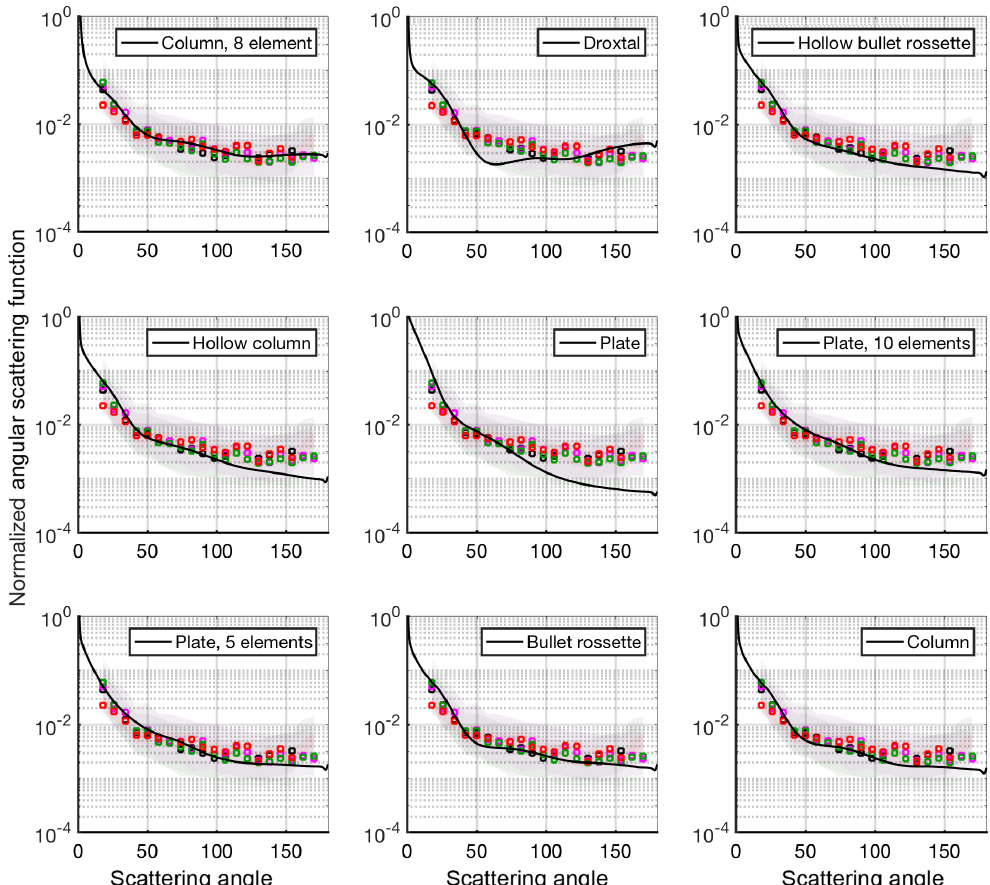
Figure 5. A comparison of the measured angular scattering functions at 532nm (data from first panel of Fig. 4) and theoretical phase functions for different habits calculated using the database of Yang et al. (2013) and assuming a size distribution as measured during the ACRIDICON-CHUVA campaign. All calculations were made assuming severely roughened surfaces. Both the measurements and the model results are normalized to the total intensity between 18 and 170 ◦